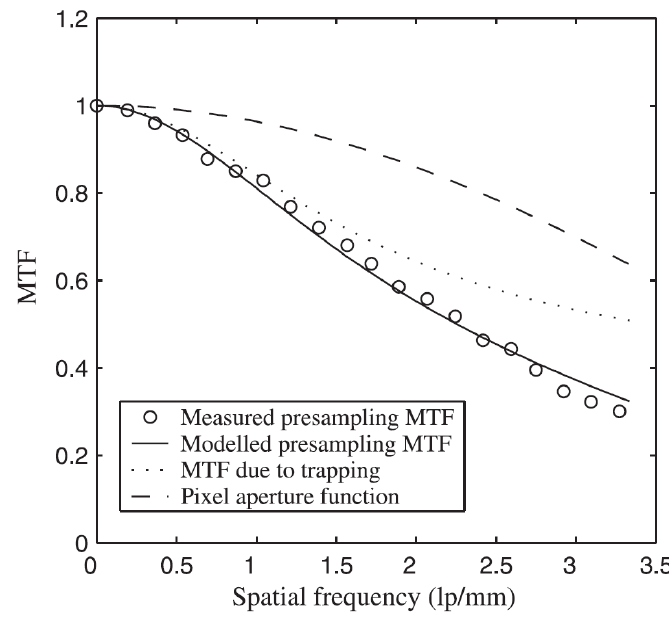
Figure 11. Measured presampling MTF vs. f of a polycrystalline CdZnTe detector in comparison with a calculated MTF in which deep trapping of charge carriers is included in the model. Blurring due to charge carrier trapping in the bulk of the photoconductor cannot be neglected. The detector thickness is 300 μm and the pixe pitch is 150